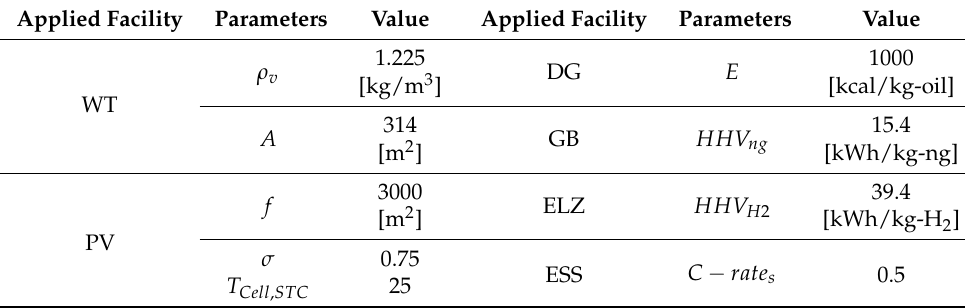
Table 3. Facilities modeling